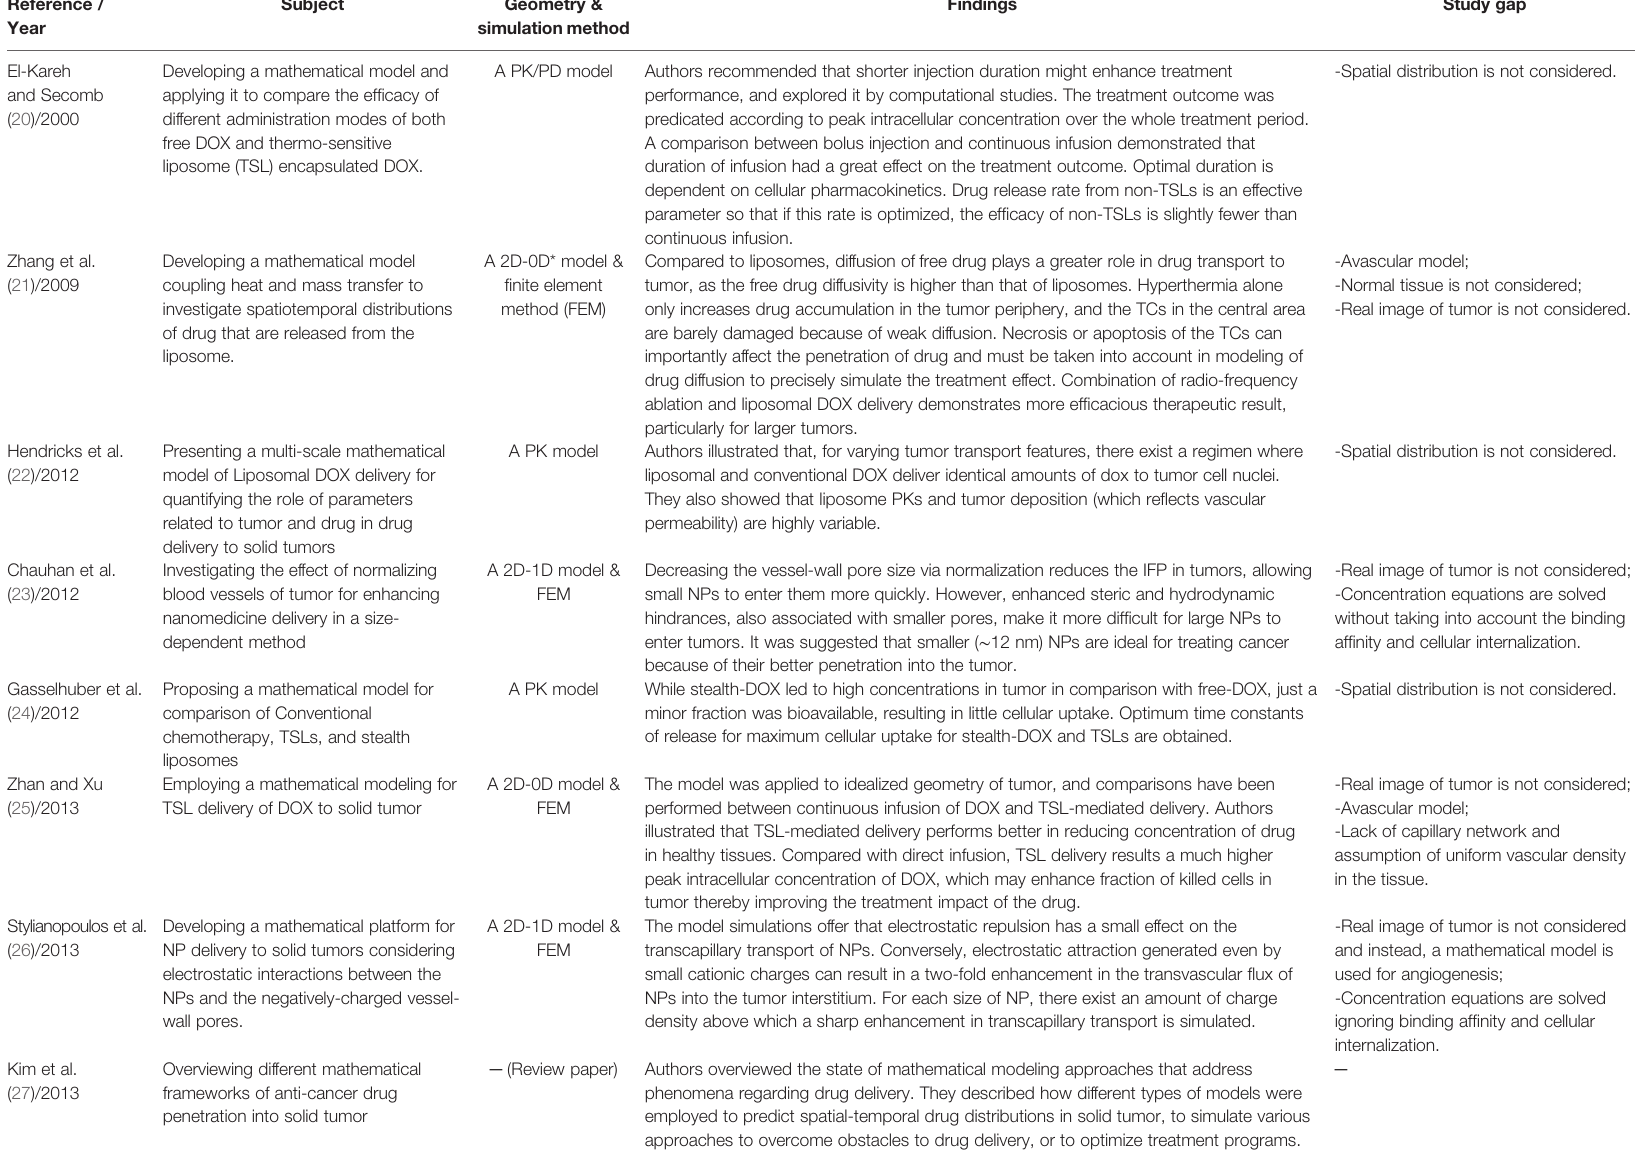
TABLE 1 | A summary of important studies conducted on employing mathematical modeling of drug-containing NPs for drug delivery to solid